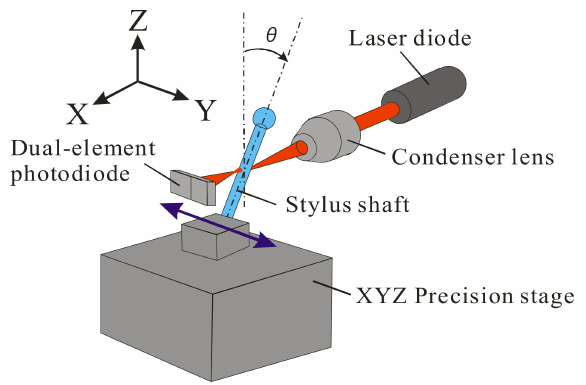
Figure 3. Experimental apparatus for measuring the sensitivity of the optical fiber probe (the stylus shaft is inclined in the X-direction).